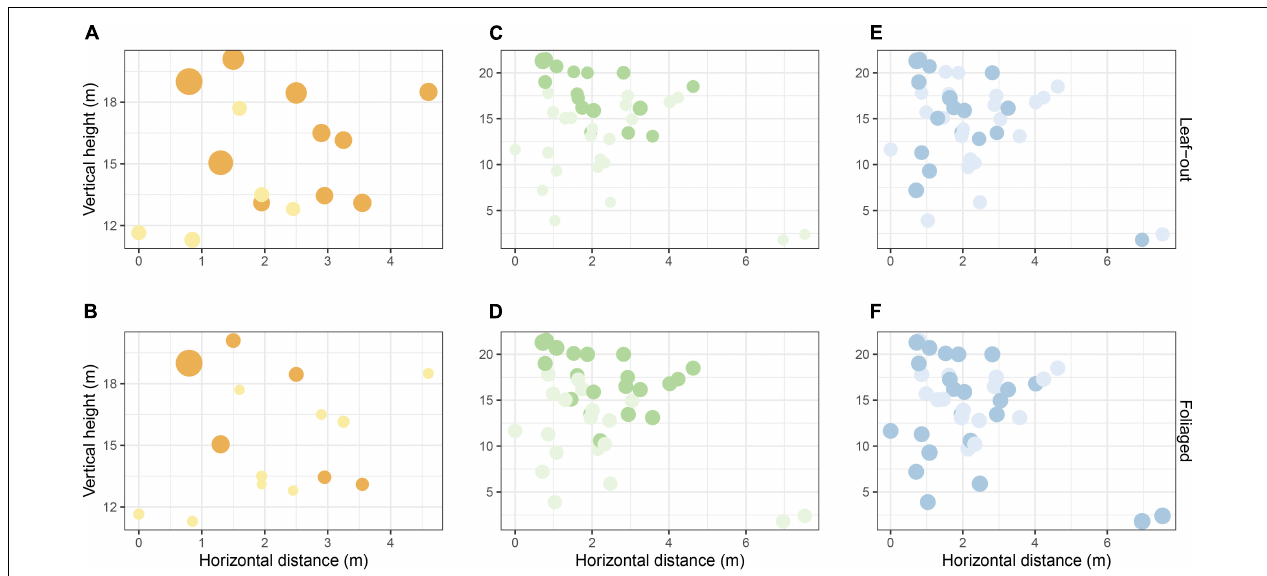
FIGURE 7 | Percentage of total variance captured by each sensor when plotted against tree height and horizontal distance to the tree center; Light yellow dots represent radiation sensors that captured less than 5% of total radiation variance and orange dots represent radiation sensors that captured more than 5% of total radiation variance (A,B) ; Light green dots represent temperature sensors that captured less than 2.5% of total temperature variance and dark green dots represent temperature sensors that captured more than 2.5% of total temperature variance (C,D) ; Light blue dots represent RH sensors that captured less than 2.5% of total RH variance and dark blue dots represent RH sensors that captured more than 2.5% of total RH variance (E,F) . All dots were size-mapped for percentage variance